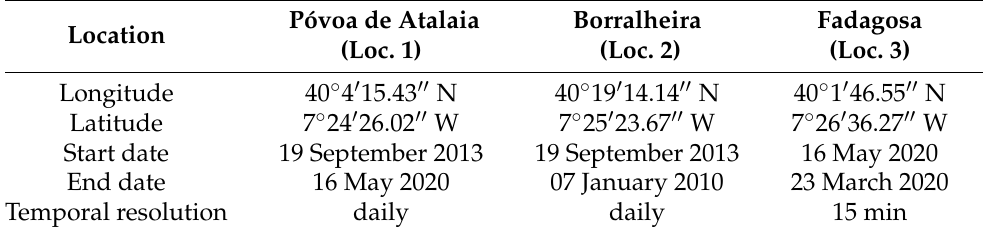
Table 1. Details of the locations in the